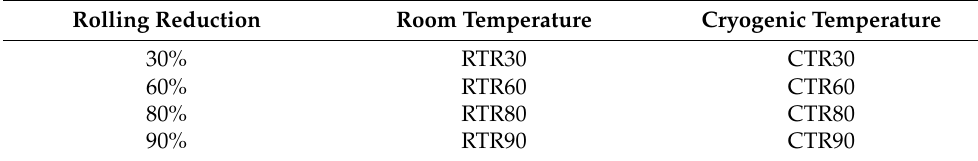
Table 2. The details of the abbreviation.